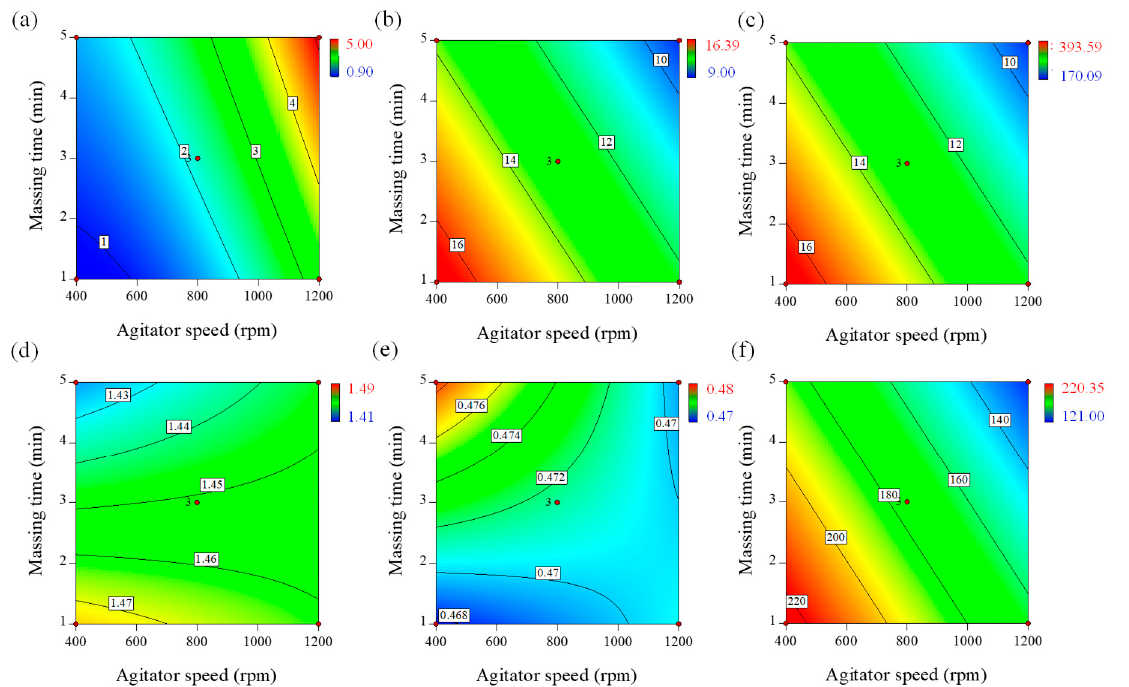
Figure 2. Contour plots correlating response factors (IQAs) to optimize process parameters of high-shear wet granulation for the telmisartan test tablet. ( a ) Granule hardness, ( b ) Carr’s index, ( c ) Granule size, ( d ) True density, ( e ) Bulk density, and ( f ) Granule flow energy (FE).